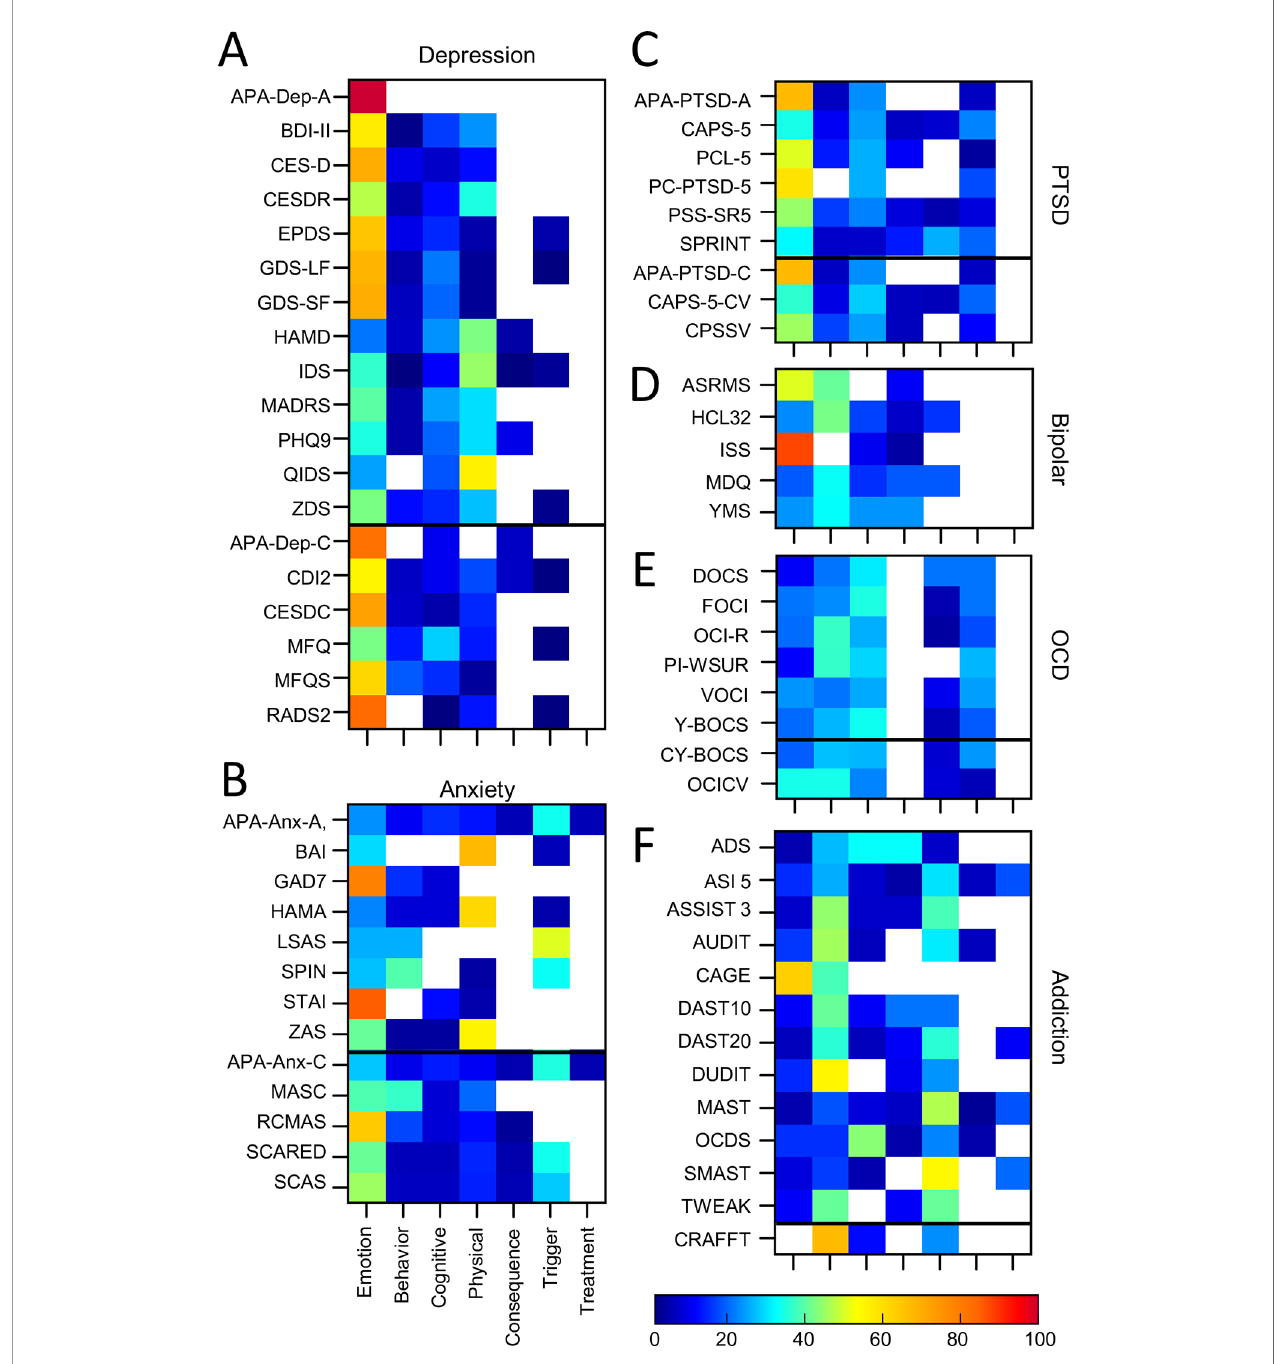
FIGURE 6 | Proportion of symptom themes. Proportion of symptom themes (%) across individual assessment tools within individual disorders. (A) Depression. (B) Anxiety. (C) PTSD. (D) Bipolar. (E) OCD. (F) Addiction. Black line denotes delineation between adult (top) and pediatric (bottom) tools. See Supplementary Table 5 for a list of